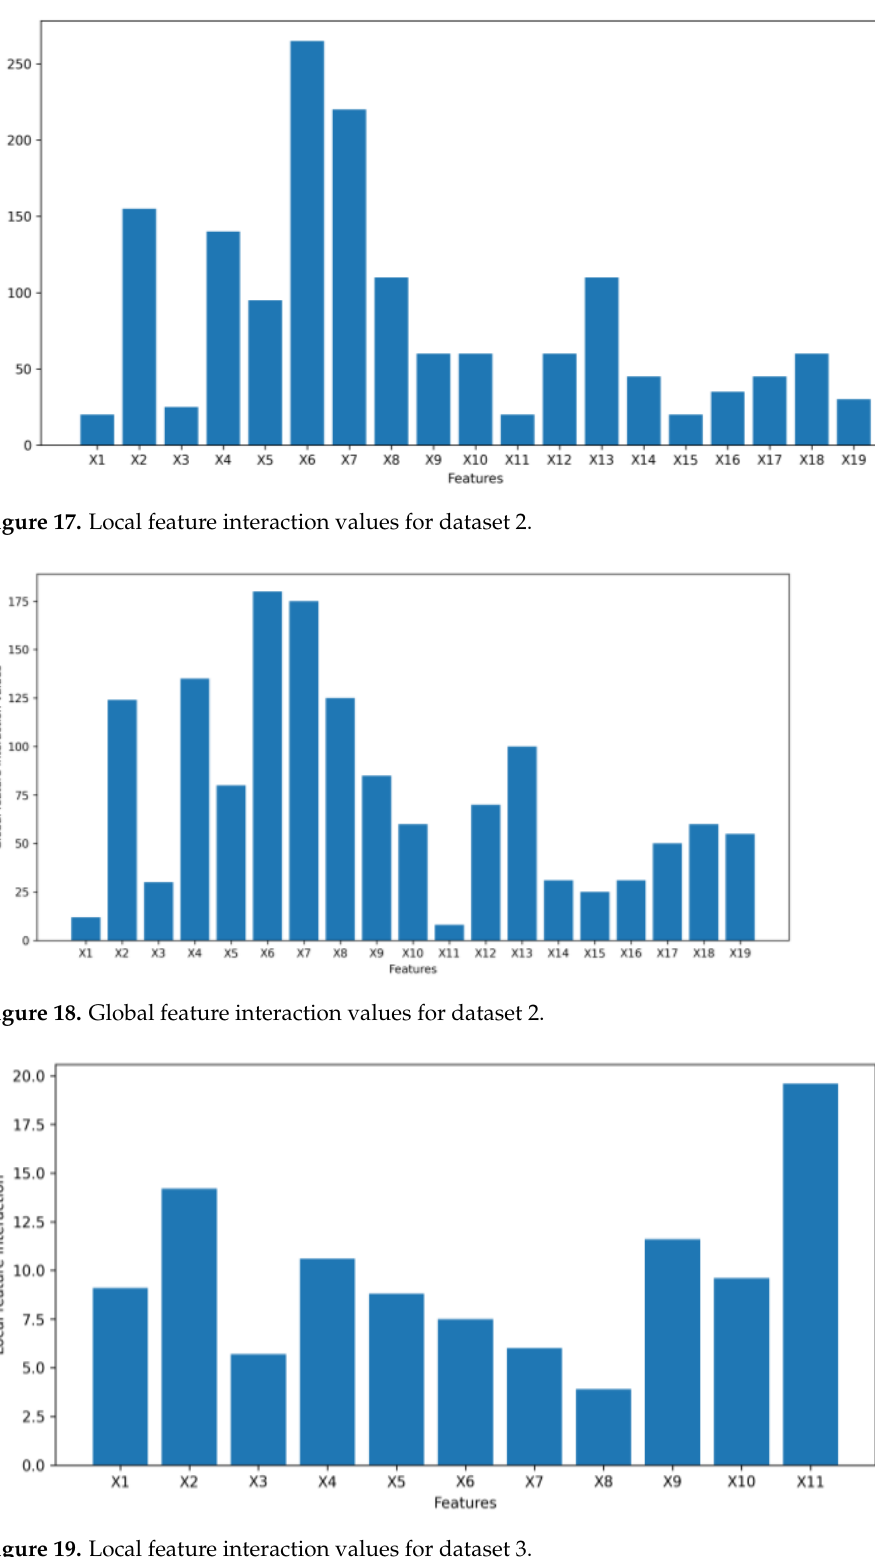
Figure 20. Global feature interaction values for dataset 3. 5. Discussion Through four experiments, the sensitivity-based method shows three major ad- vantages compared with the visualization method mentioned in Section 2. First, the method can intuitively demonstrate feature importance and interaction numerically and graphically. Second, the experimental results prove that the proposed approach can pro- vide both local and global interpretations. Third, the method is computationally inexpen- sive. The computational time to calculate either feature importance (first-order partial de- rivatives) or feature interaction (second-order partial mixed derivatives) in the application examples is on the order of seconds on a Google cloud platform. Although computational time will increase as the dataset size increases, this sensitivity-based method is still ex- pected to explain the impacts of features on the latent space of a VAE in a very efficient way. However, this sensitivity-based method also has some restrictions. One limitation is that after calculating the sensitivity, relative importance, and feature interaction, data sci- entists still need to use their domain knowledge and experience to determine threshold values for the first and second derivatives to eliminate features. Another limitation is this sensitivity-based method heavily relies on the training of a VAE, unlike TabNet which can be used as a preprocessing step to identify important features. The proposed method re- quires fine-tuning of VAE hyperparameters for accurate interpretations. If the latent space of a VAE fails to generalize well and extract the key information from an input dataset, interpretations may not be able to provide any useful information. In addition, the pro- posed method may generate different results due to factors such as random initialization, data variability and VAE hyperparameter tuning. However, these differences can be min- imized by using a fixed seed for initializing the weights, stabilizing the random selection of data samples in mini-batch updates, and maintaining consistent VAE hyperparame- ters.. As emphasized in Section 1, the main objective of this paper was to study the impact of input features in an original tabular dataset on learning the latent representation of the tabular dataset in a VAE model, which is used to generate synthetic data. This paper